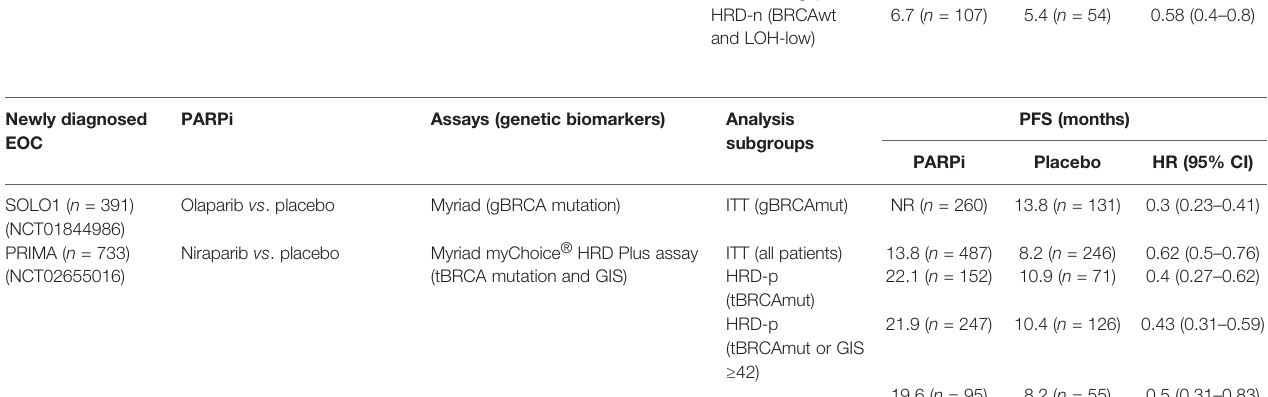
Newly diagnosed